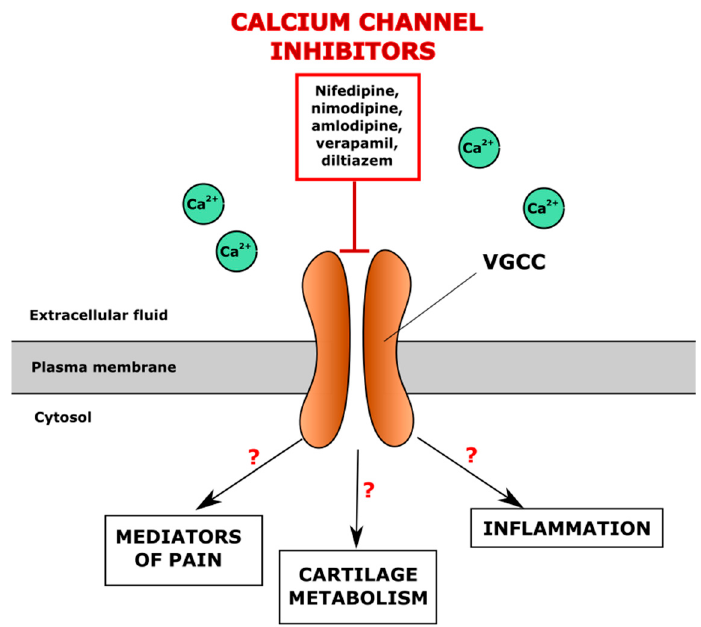
Figure 2. Potential regulation of iCa 2+ levels in the chondrocyte through the direct blocking of volt- age-gated calcium channels (VGCC) by antihypertensive drugs, VGCC